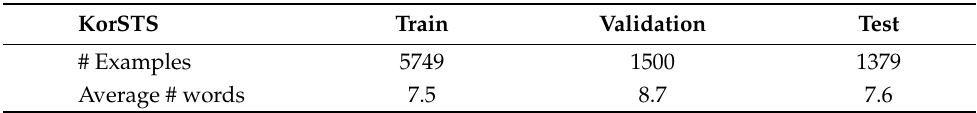
Table 1. Statistics for KorSTS. We use the open Korean sentence textual similarity dataset KorSTS to train a highly generalized model in industry domain.